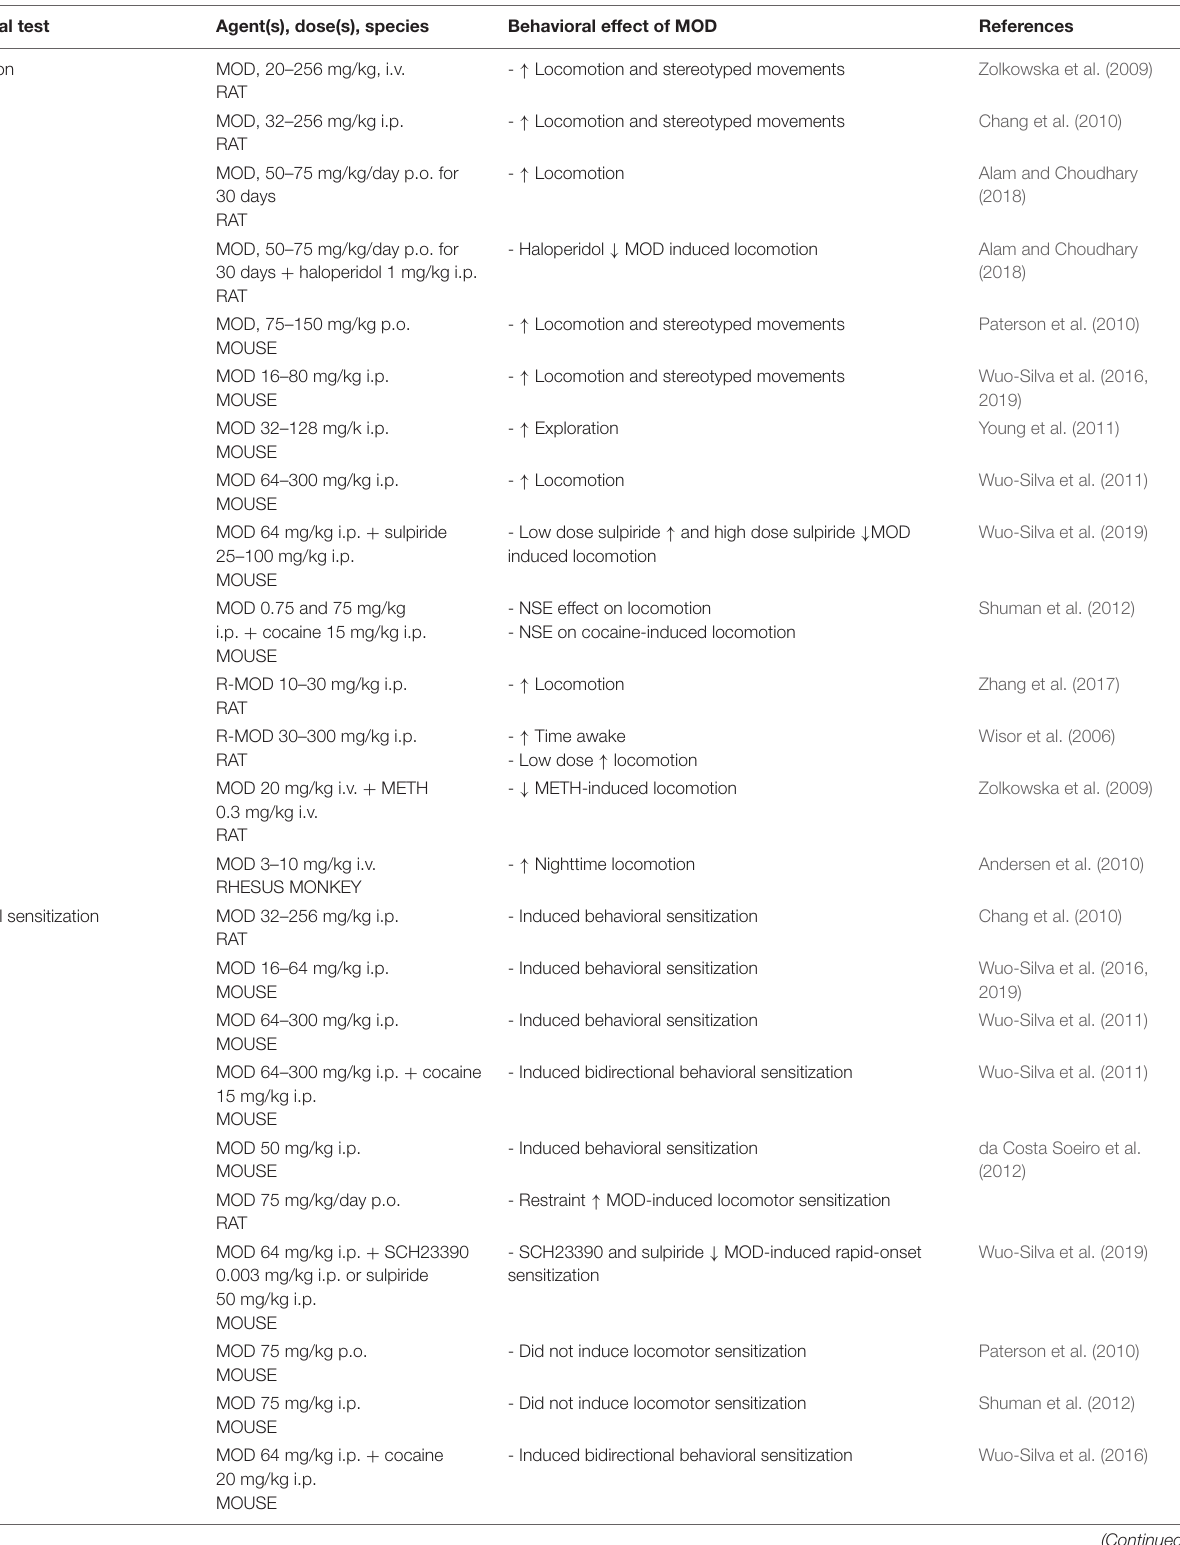
TABLE 3 | MOD effects on preclinical behavioral animal models related to PSUD. Behavioral test Agent(s), dose(s), species Behavioral effect of